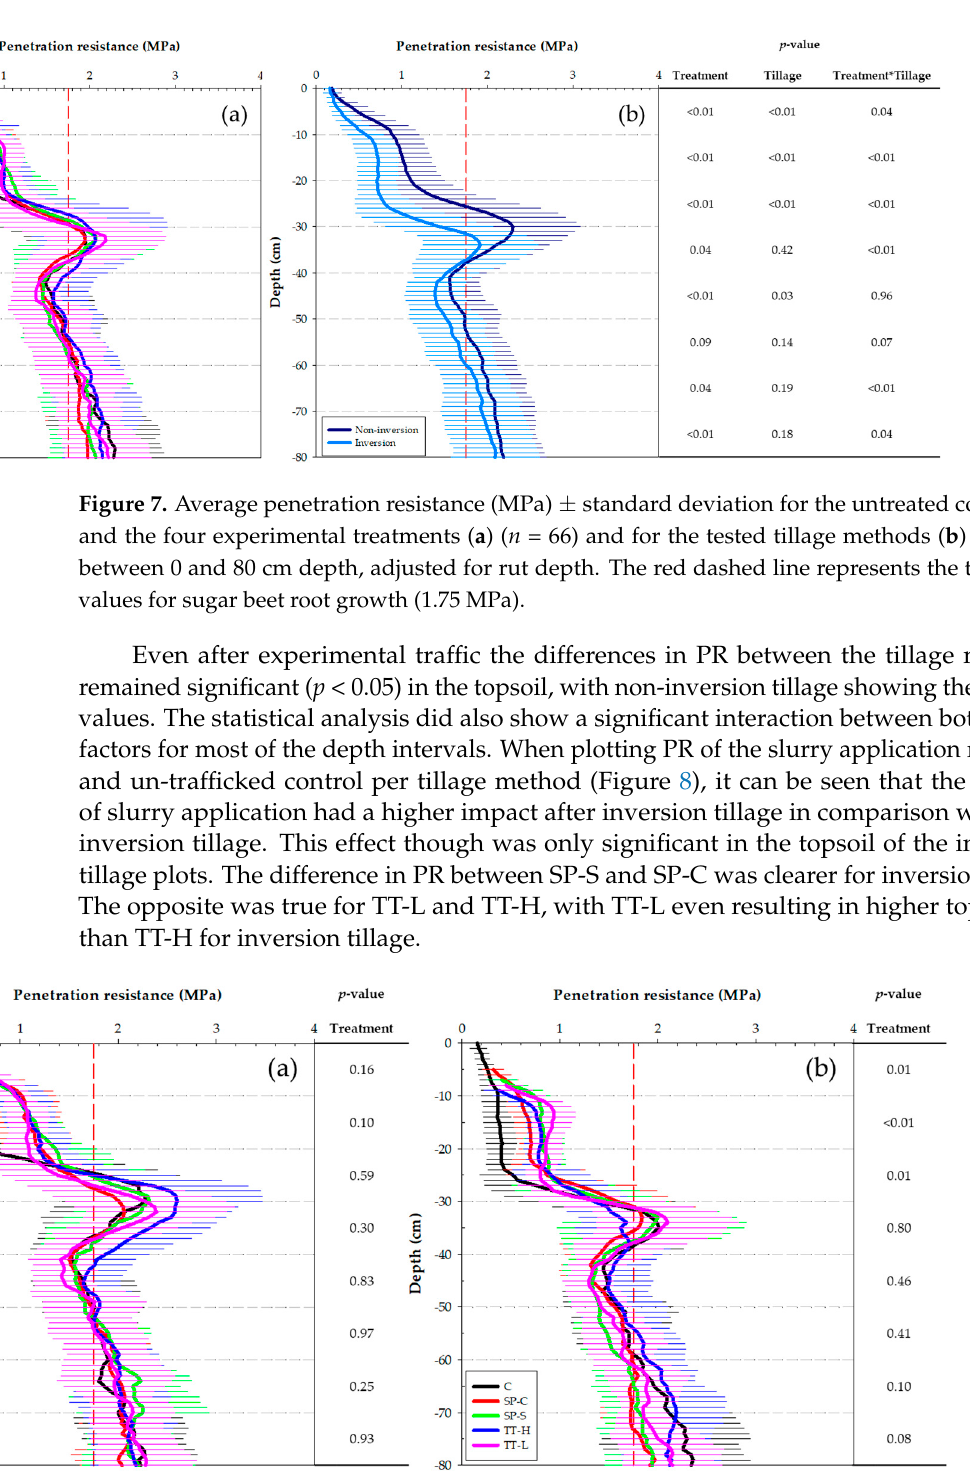
Figure 8. Average penetration resistance (MPa) ± standard deviation of the untreated control (C) and the four experimental treatments ( n = 33) for the tested tillage methods: non-inversion ( a ) and inversion ( b ), adjusted for rut depth. The red dashed line represents the threshold values for sugar beet root growth (1.75 MPa).